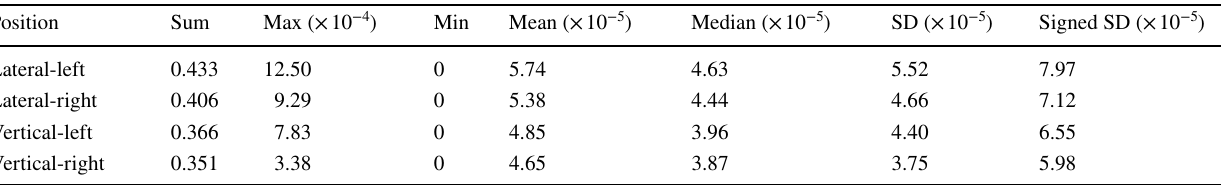
Table 3 Statistics of the errors from LOO